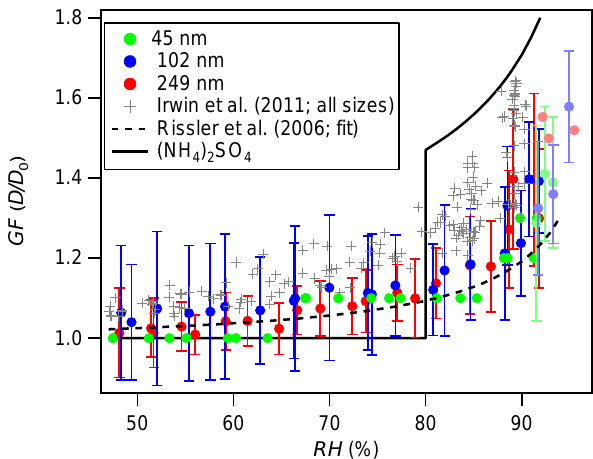
Figure 13. Humidogram (dependency of growth factor on RH), taken between 14:00 and 20:30UTC on 21 July. The fainter points at higher RH were taken between 13:30 and 14:30UTC on 23 July. The humidogram data from Irwin et al. (2011), and the humidogram fit from Rissler et al. (2006) are also shown, for comparison. The black line shows the modelled humidogram for ammonium sulfate (Topping et al., 2005) for